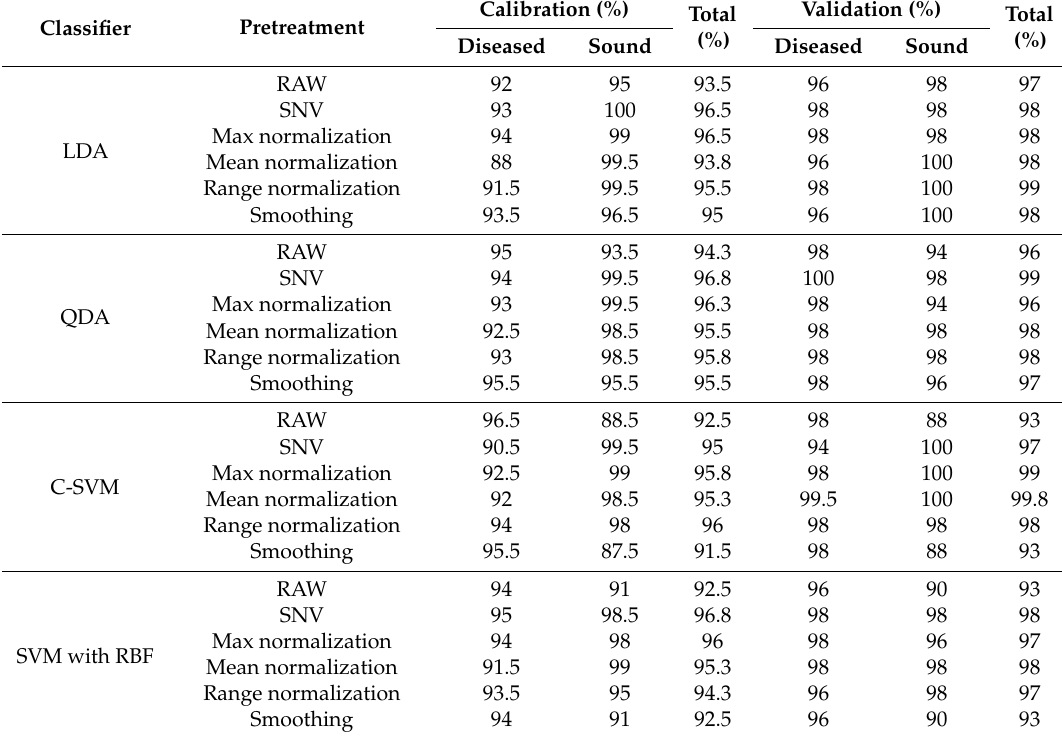
Table 4. Calibration and validation results of each classifier with different pretreatment methods using three subset